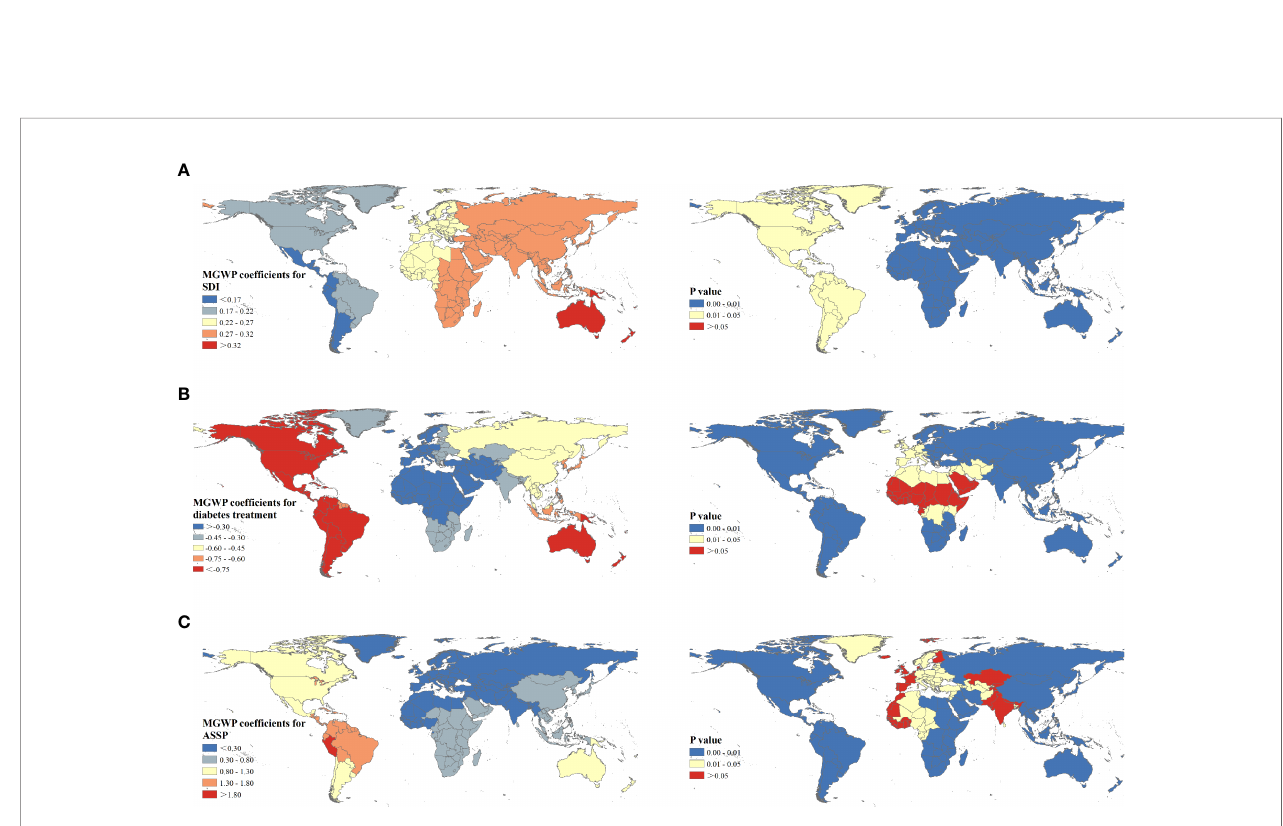
FIGURE 4 | Spatial patterns of regression coef fi cients and corresponding P values for socio-demographic index (A) , diabetes treatment index (B) , and age- standardized smoking prevalence (C) among 204 countries or